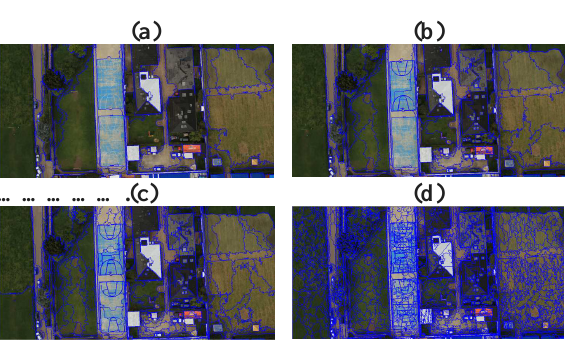
Figure 4. Aerography with a 3cm pixel size corresponding to an area in the northern Bogotá. . .Source: Elaborated by authors.